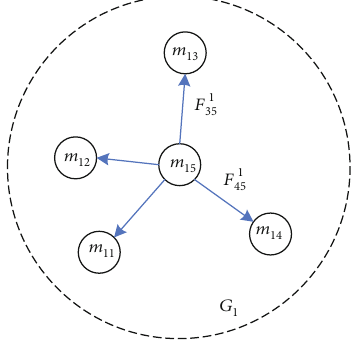
Figure 9: Illustration of the gravity